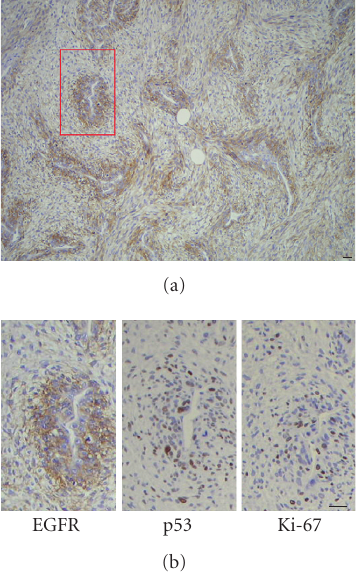
Figure 2: Heterogeneous expression of EGFR (a) and colocalization with high-grade Ki-67 and p53-positive (b) areas. Scale bar represents 15 µ